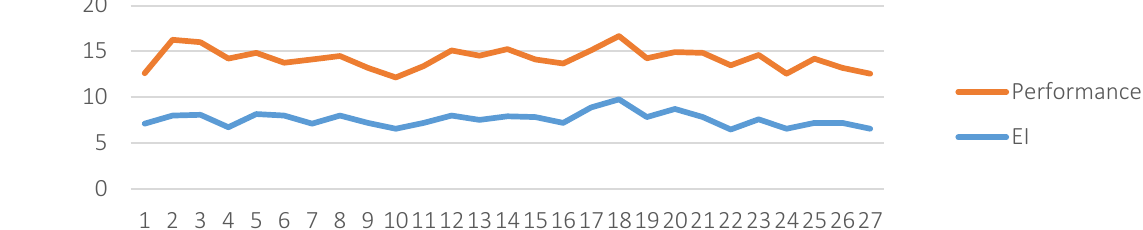
Figure 4. Correlation between EI of male students and their